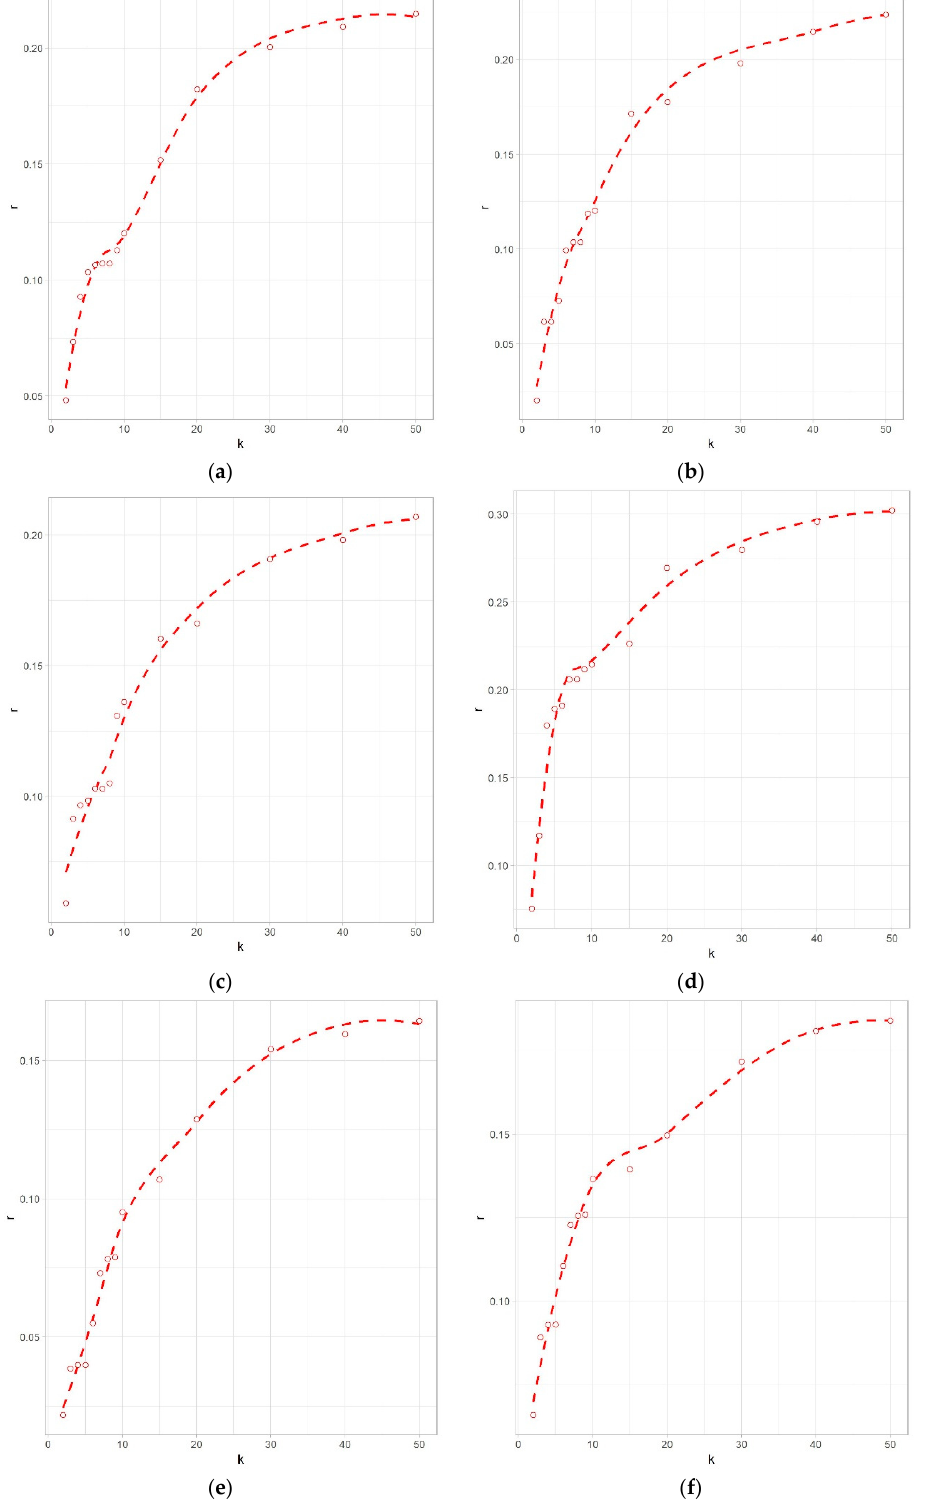
Figure 3. Accuracy of: ( a ) Neuroticism across k dimensions, ( b ) Extraversion across k dimensions, ( c ) Conscientiousness across k dimensions, ( d ) Openness to Experience across k dimensions, ( e ) Agreeableness across k dimensions, and ( f ) SWB across k dimensions. It is important to note that the accuracy plots utilised predicted data that was obtained from training the algorithm on 100% of the sample, rather than iteratively through 10